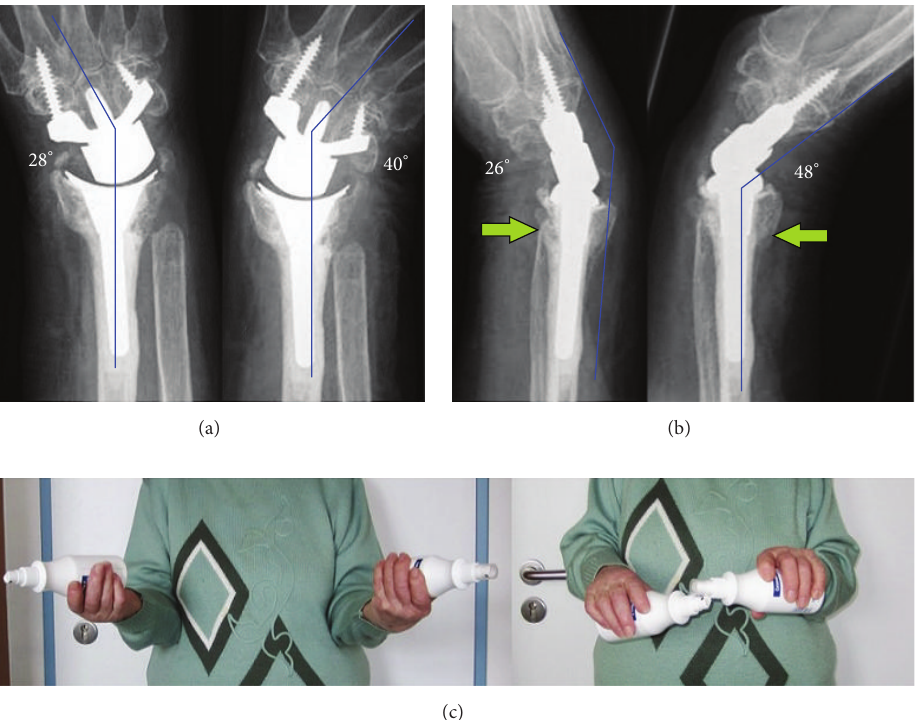
Figure 5: Case report 2 (1-year follow-up): (a) AP radiographs with terminal range of motion: no signs of loosening of either implant and no radioulnar impingement; (b) lateral radiographs with terminal range of motion: no subluxation of distal ulna stump ( arrows ); (c) clinical photo with supination-pronation arc on both